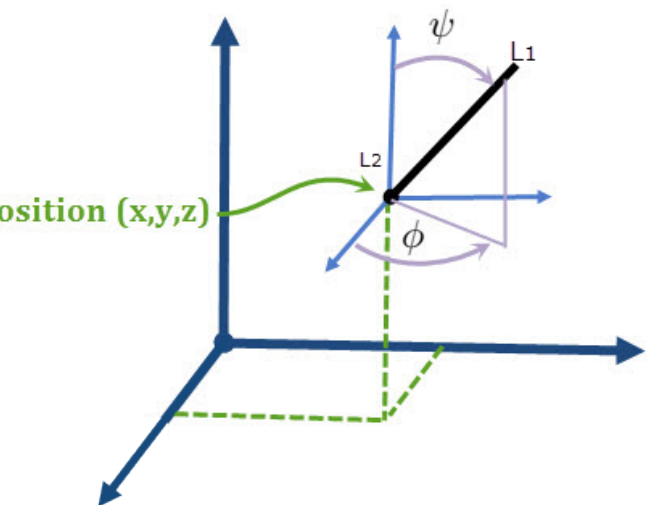
Figure 4. Positioning a segment ( L 1 L 2 ) in a 3D space.